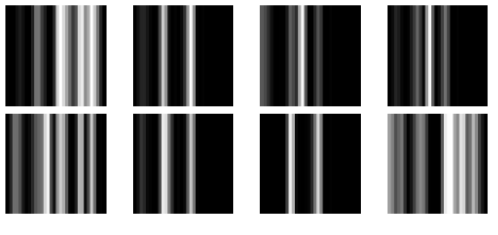
Figure 4. Sample grayscale images.